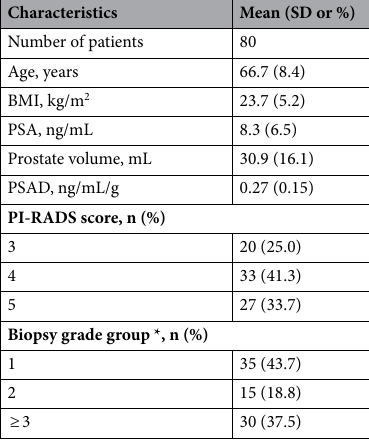
Table 1. Patient characteristics. *Biopsy grade groups: 1 = Gleason 6 (or less); 2 = Gleason 7 (3 + 4); 3 = Gleason 7 (4 + 3); 4 = Gleason 8; 5 = Gleason 9 or 10. BMI Body mass index, PSA Prostate-specific antigen, PI-RADS Prostate Imaging Reporting and Data